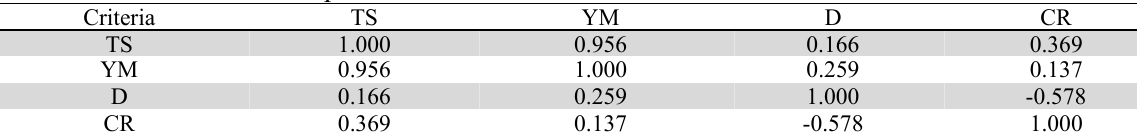
Correlation matrix for Example 4